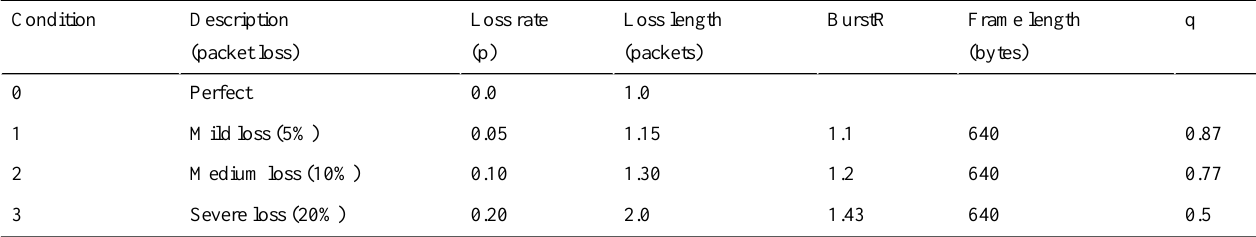
Table 3. Parameters of the voice over Internet protocol (VoIP)